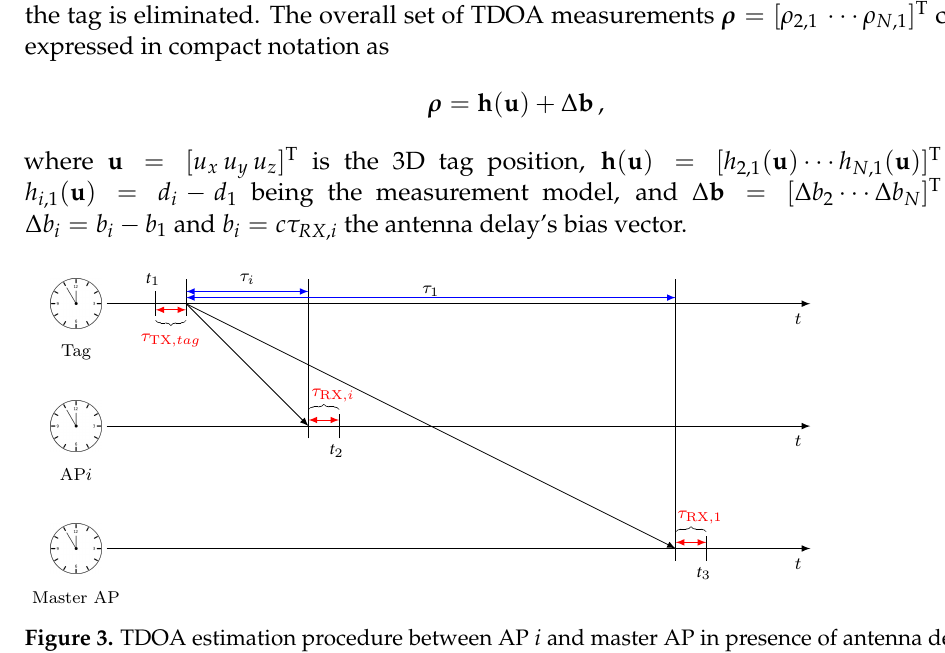
Figure 3. TDOA estimation procedure between AP i and master AP in presence of antenna